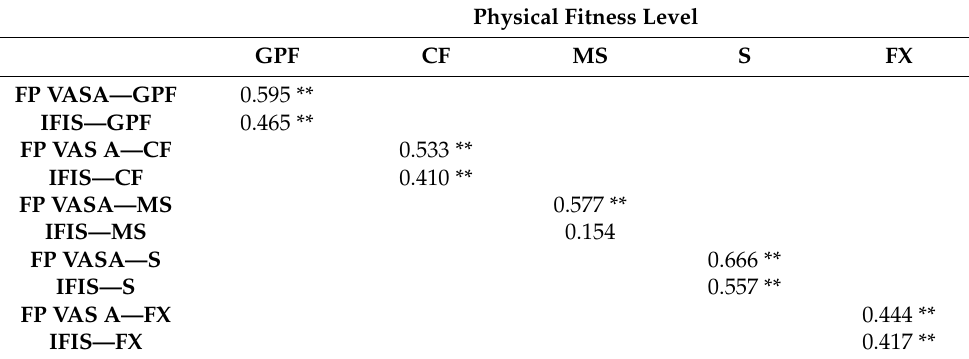
Table 2. Relationship between FP VAS A and IFIS with the level of